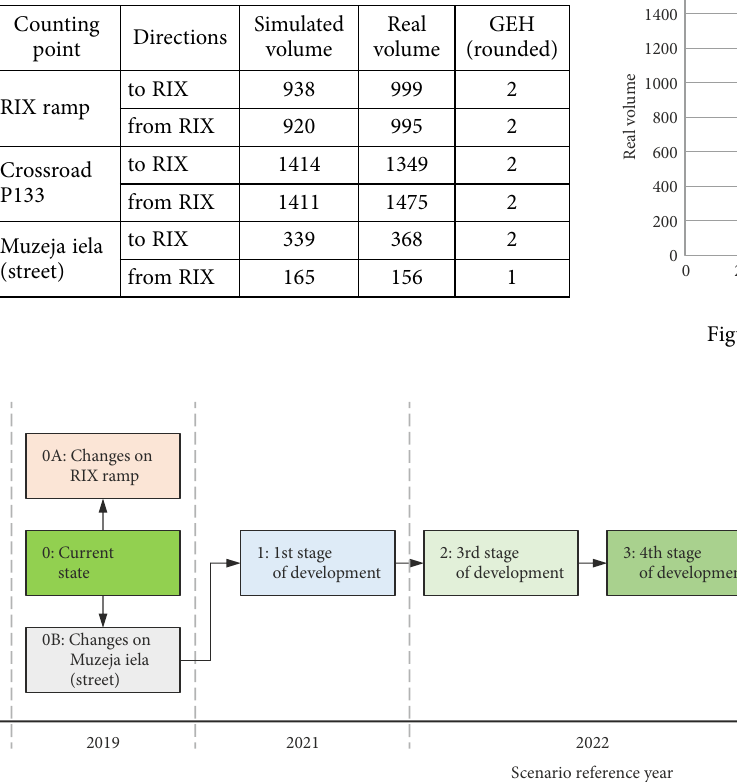
Table 2. Results of validation using GEH index